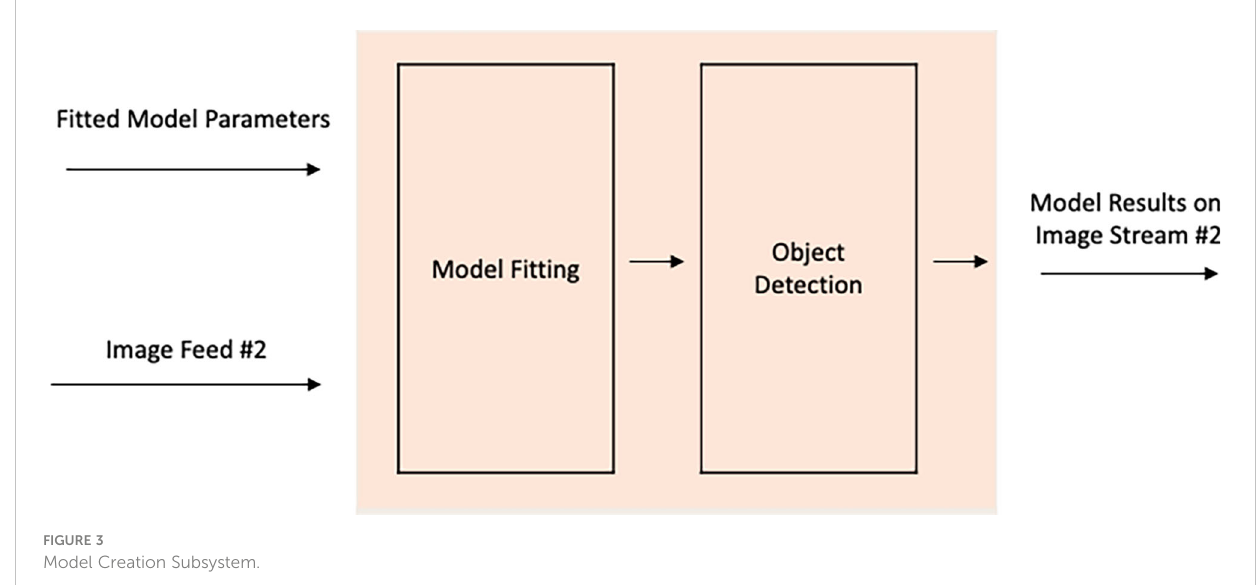
FIGURE 3 Model Creation Subsystem.